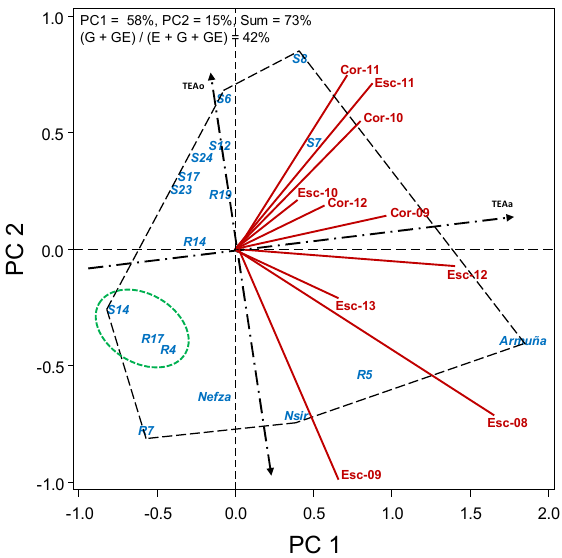
Broomrape response of accessions over environments is further shown by HA-GGE biplot (Figure 3) in which accessions to the left of TEAo axis have lower broomrape infection, this being more stable as the closer they are to TEAa axis. Like this, accessions S14, R17, and R4 are the more resistant and stable, with R7 being also among the more resistant ones, but being more affected by the environment. ones, but being more affected by the environment.